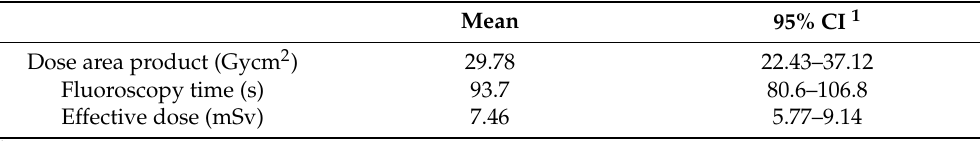
Table 2. Intraoperative patient radiation